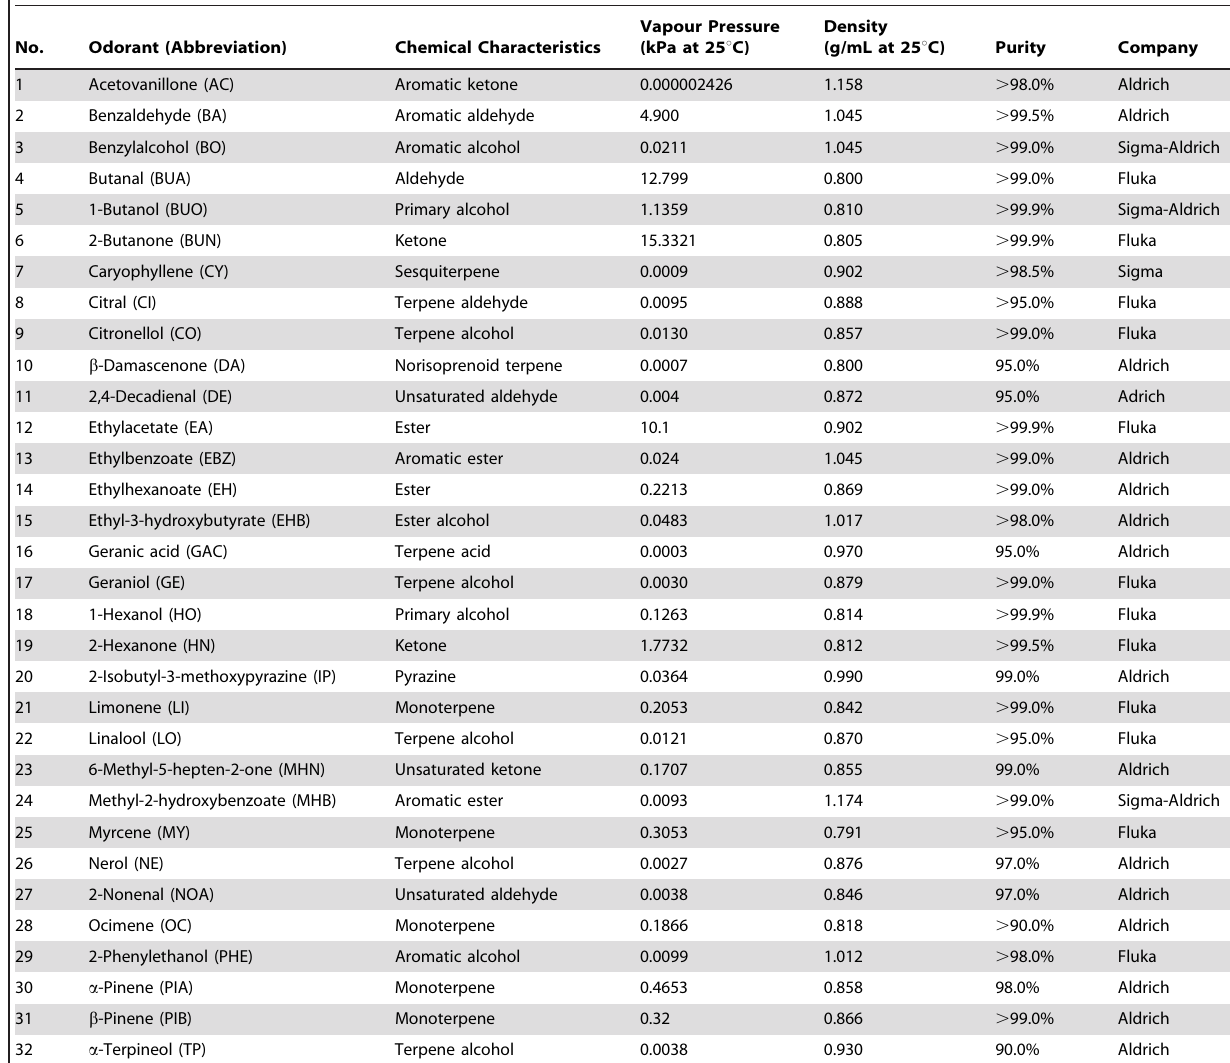
Table 1. Names and Characteristics of the Odorants